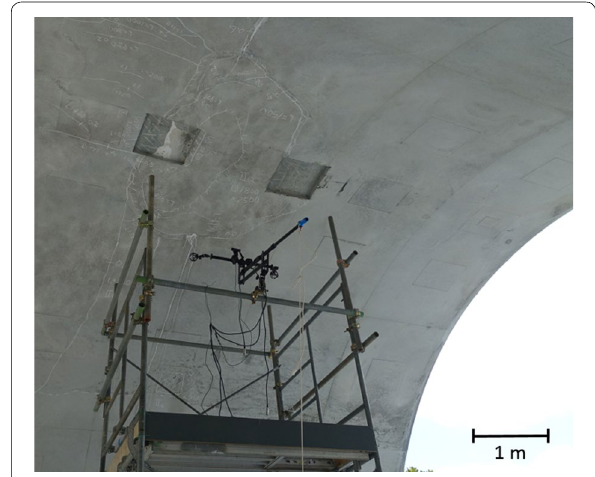
Fig. 13 Experimental tunnel for field testing. This tunnel is identi- cal to many found in service but has been made so that it would generate natural defects after a short period after its production. This provided us with natural defects in field environment to test our proposed